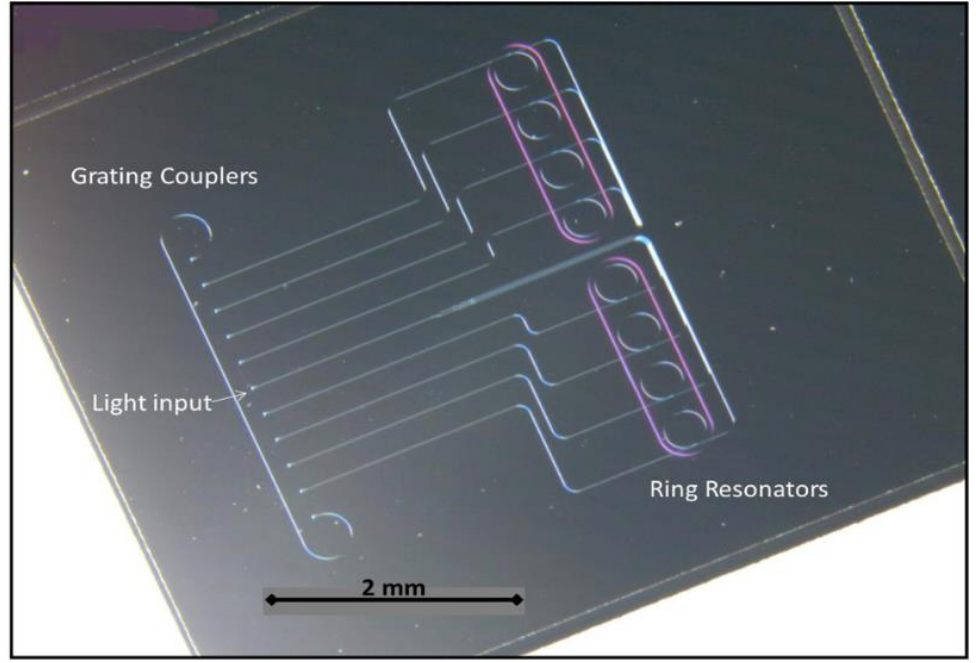
Figure 6. Fabricated PIC biosensor with ring resonators for the detection of PCV2 viruses on swine livestock. Reprinted with permission from [86], copyright 2019, MDPI.